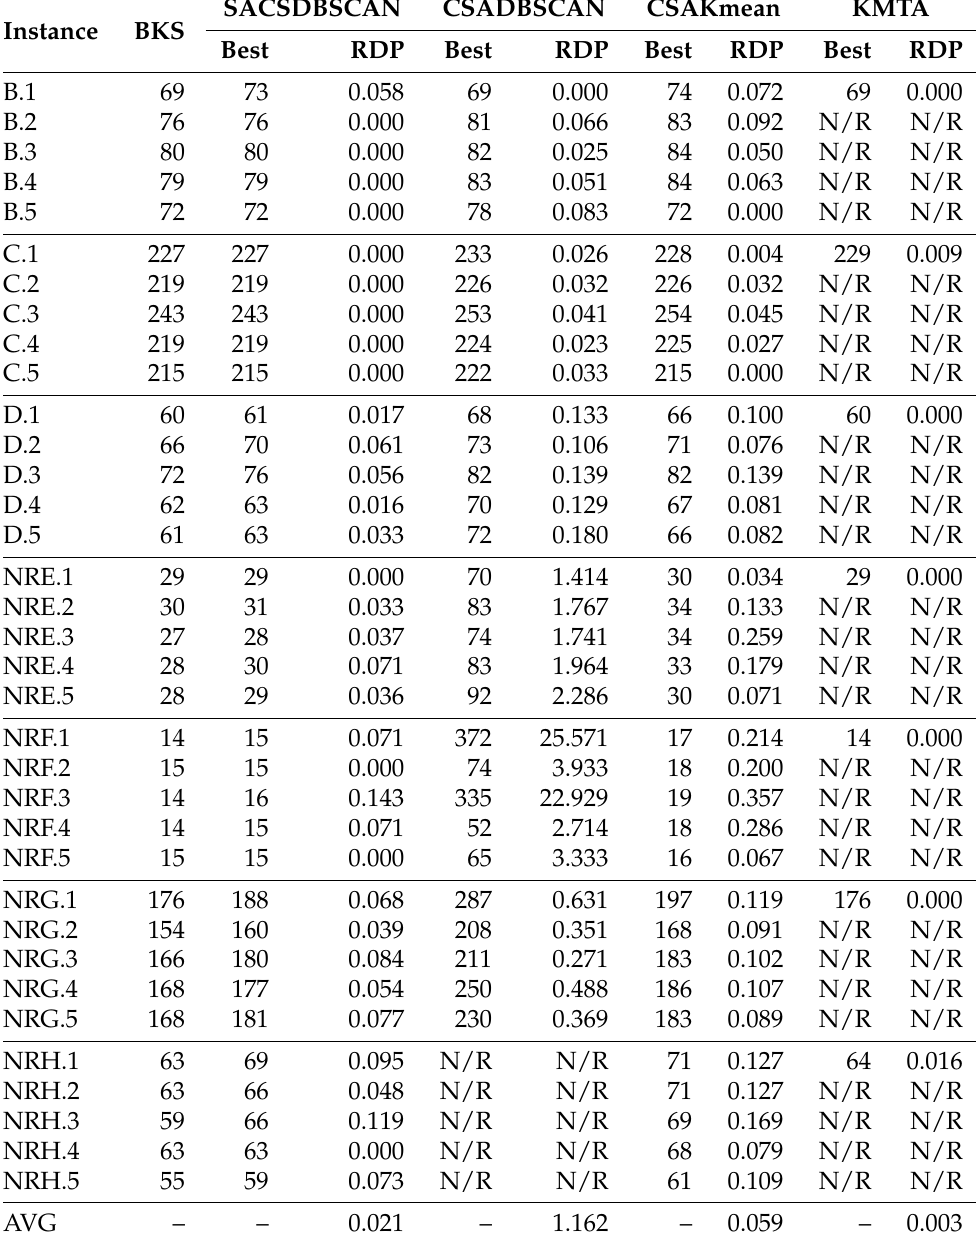
Table 21. Best values reached by an improved bio-inspired algorithm with ML that solve the set covering problem Instances B, C, D, NRE, NRF, NRG, and